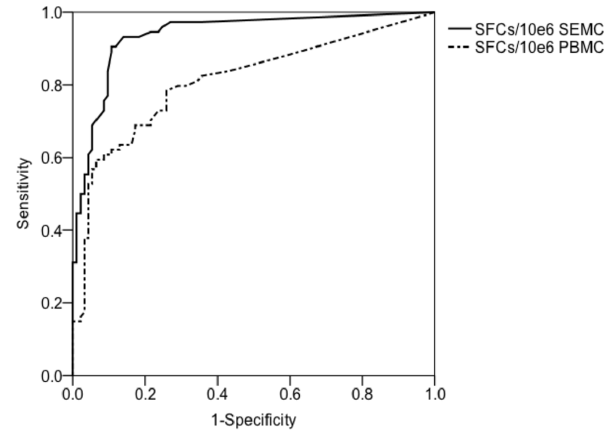
Figure 2. ROC curves for T-SPOT.TB on SEMC and PBMC in patients with suspected tuberculous serositis. The AUC of ROC curve was 0.938 (95%CI: 0.900–0.975,P , 0.001) for T-SPOT.TB on SEMC, which was higher than that of T-SPOT.TB on PBMC (0.811,95%CI: 0.742– 0.880,P , 0.001). PBMC: peripheral blood mononuclear cell; SEMC: serous effusion mononuclear cells; ROC: receiver operating character- istic; AUC: area under the receiver operating characteristic curve.